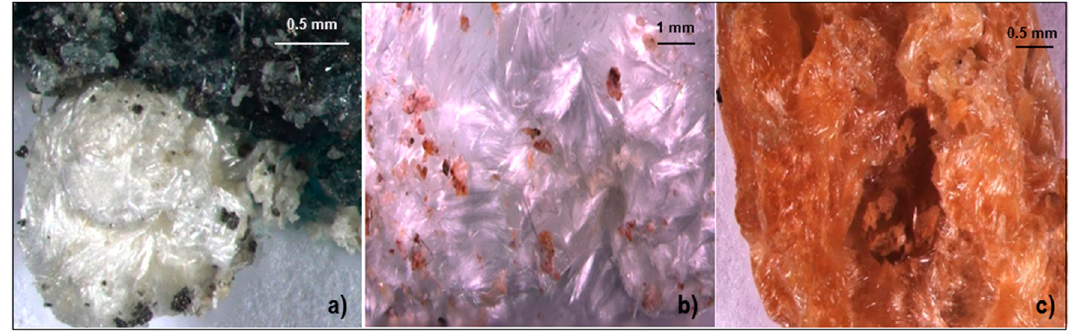
Figure 12. Stereomicroscope images of halotrichite ( a ), pickeringite ( b ) and of the iron-rich pickeringite ( c ).